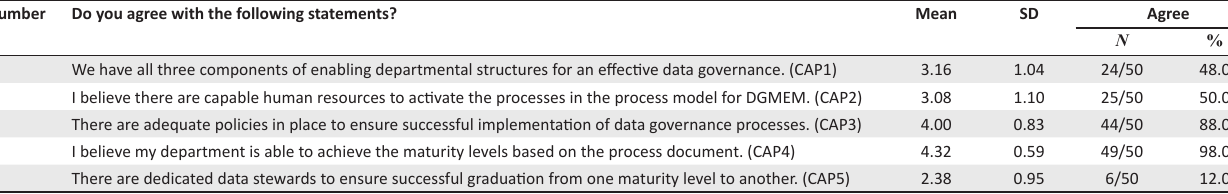
TABLE 4: People, policies and process capabilities ( N = 50).